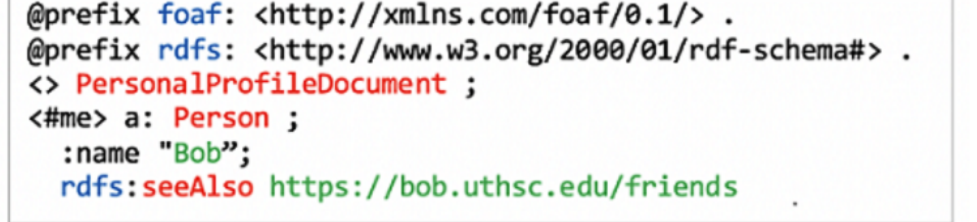
Figure 3. Bob’s main PHL profile document with a reference to his friends’extended